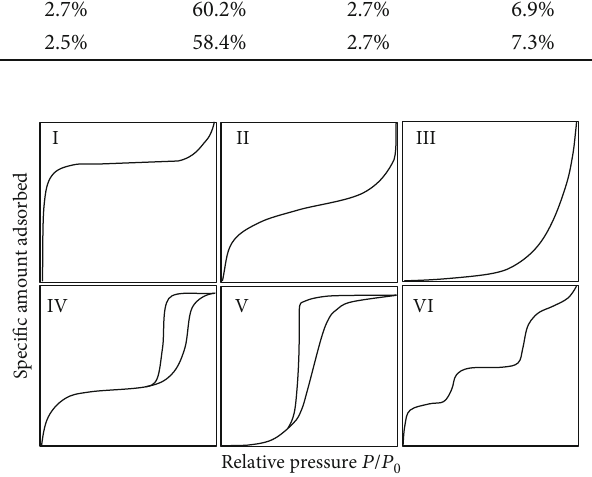
Figure 1: Classi fi cation of adsorption isotherm